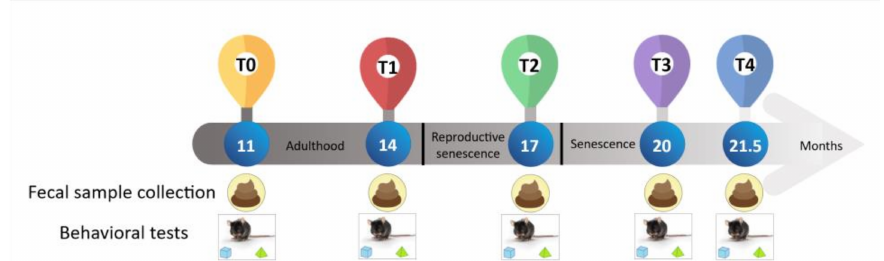
Figure 1. Flow diagram of experimental plan with the chosen time points: 11, 14, 17, 20, and 21.5 months of mice age, corresponding to T0, T1, T2, T3, and T4, respectively. It has to be noted that T0 and T1 belonged to adulthood, T2 to reproductive senescence, and T3 and T4 to senescence. At each time point, behavioral tests were performed and stool samples were